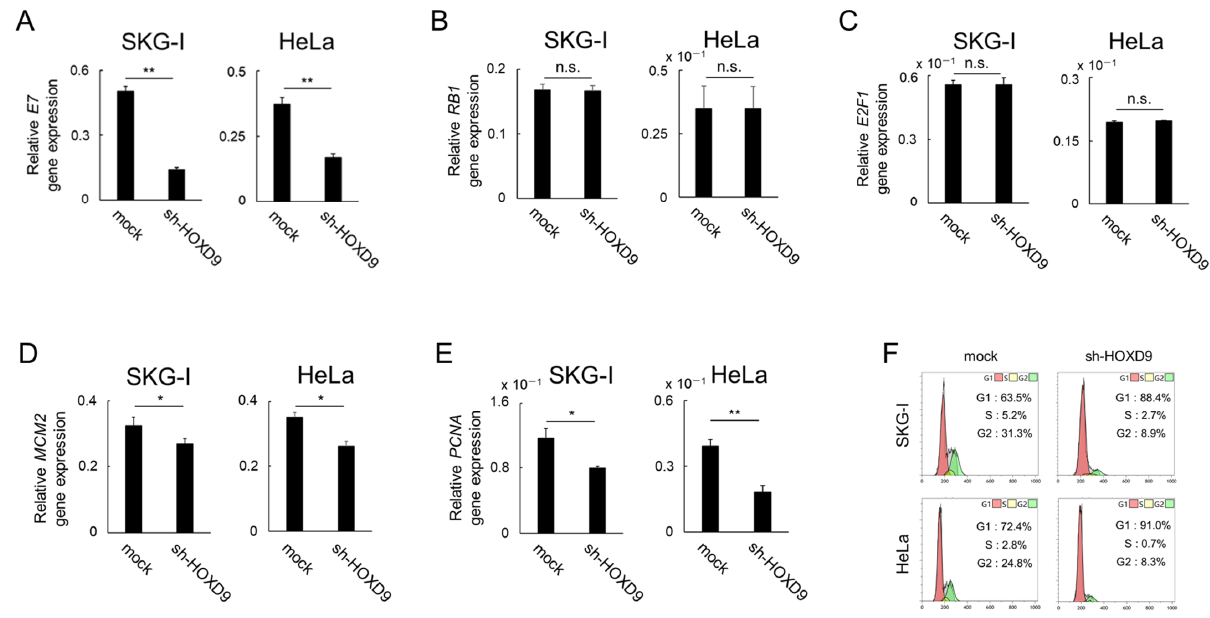
Figure 3. Knockdown of HOXD9 gene causes G1 arrest through low E7 expression and decreased E2F activity. SKG-I and HeLa cells were transfected with shRNA-HOXD9 (sh-HOXD9) or shRNA-empty vector (mock). ( A – E ) Total RNA was extracted and E7 ( A ), RB1 ( B ), E2F1 ( C ), MCM2 ( D ), and PCNA ( E ) mRNA was evaluated by real-time RT-PCR at 48 h post-transfection. (means ± SD; n = 3) ( F ) Cell cycle analysis by flow cytometry. Representative cytograms of the cell cycle distribution at G1 (red), S (yellow), and G2 (green) phases are shown. * p < 0.05, ** p < 0.01.